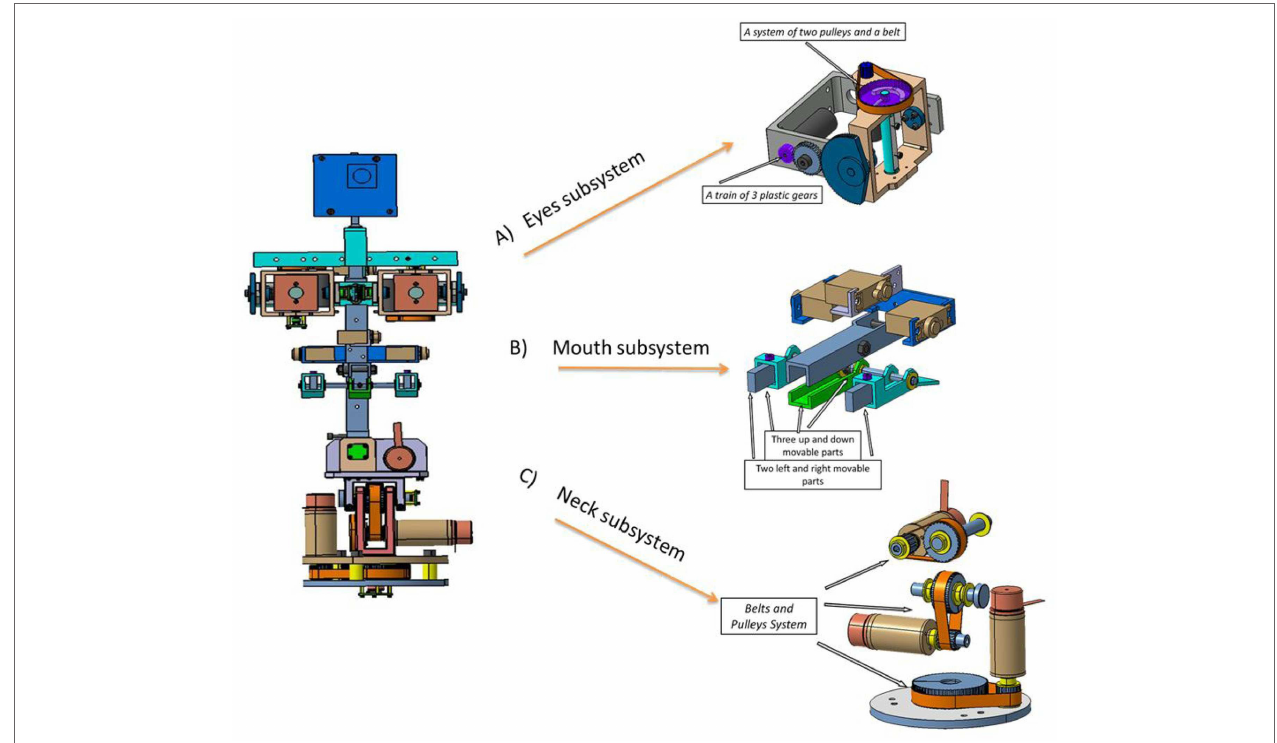
FIGURE 8 | Design of the HYDROïD head mechanism and main sub-parts: (A) Eye subsystem, (B) Mouth subsystem and (C) Neck subsystem .